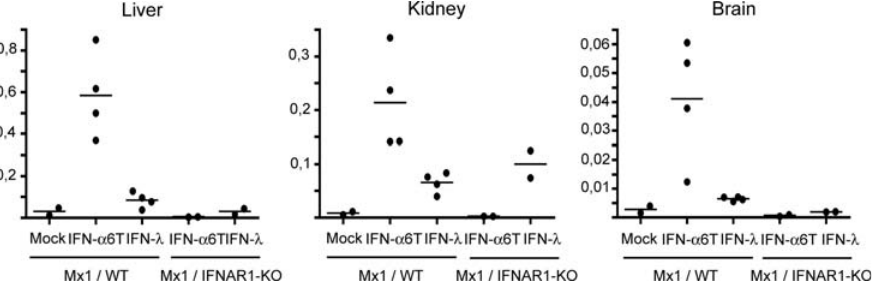
Figure 5. Mx1 gene expression induced by systemic IFN- a and IFN- l , in organs of IFNAR1-positive and IFNAR1-deficient mice. Mx1 gene transcription was analyzed by real-time RT-PCR, 7 days after electroinjection of plasmid coding for MuIFN- a 6T, MuIFN- l 3 or the empty vector (mock) in 6 week-old Mx1-positive mice (2 BALB.A2G-Mx1 and 2 B6.A2G-Mx1 mice, grouped as Mx1/WT mice) or in 8 week-old Mx1/IFNAR1-KO mice. Results are expressed as Mx1 cDNA copies per b -actin cDNA copy. Graphs present results for individual mice and the mean for each group, for one representative experiment.